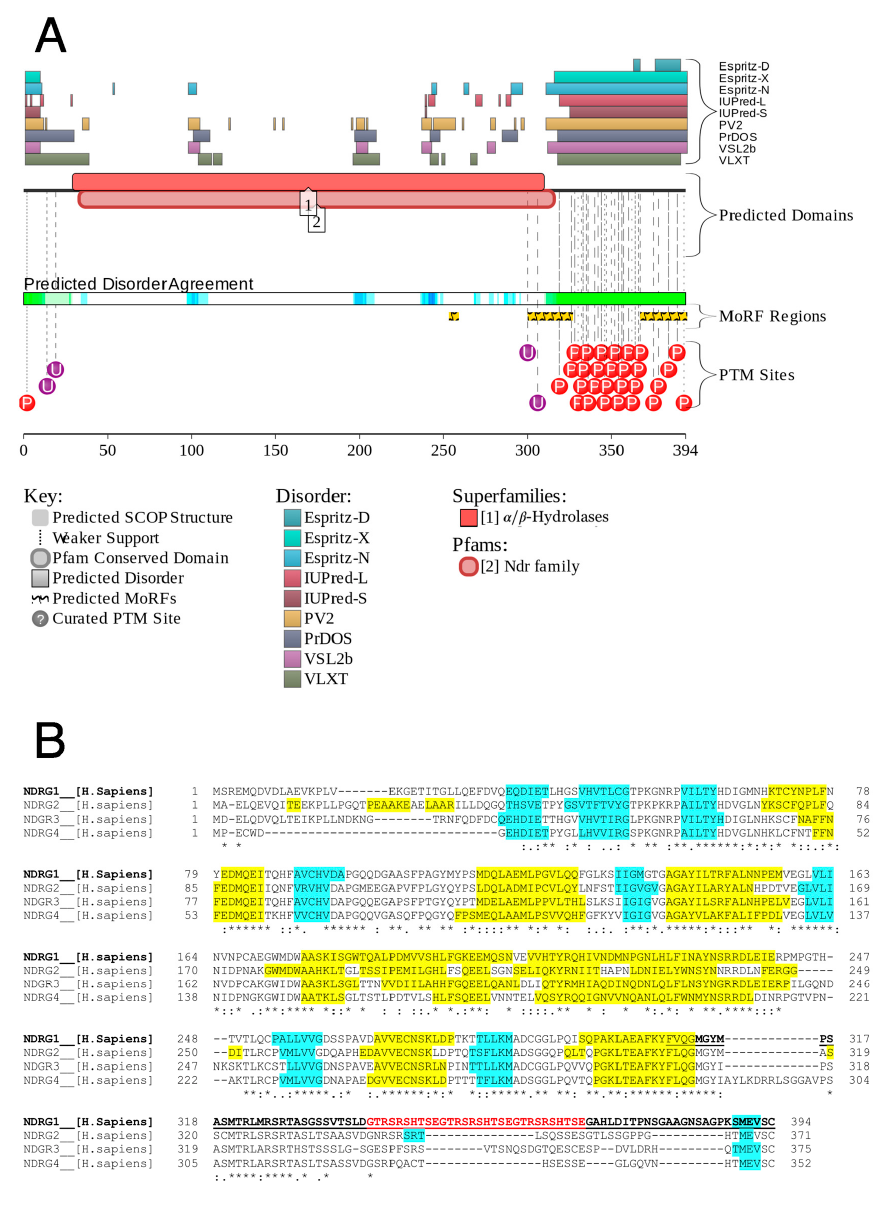
Figure 1. Analysis of the sequence of h NDRG1. ( A ) Disordered regions of the sequence of h NDRG1 as predicted by the D2P2 server (http://d2p2.pro/, accessed on 29 January 2021). The predicted dis- ordered regions (top), folded domains (middle), and disorder consensus (bottom) are indicated by bars over the residue numbers. The sites with predicted post-translational modifications are also indicated. ( B ) Prediction of the secondary structure content of h NDRG1 using the software JPred